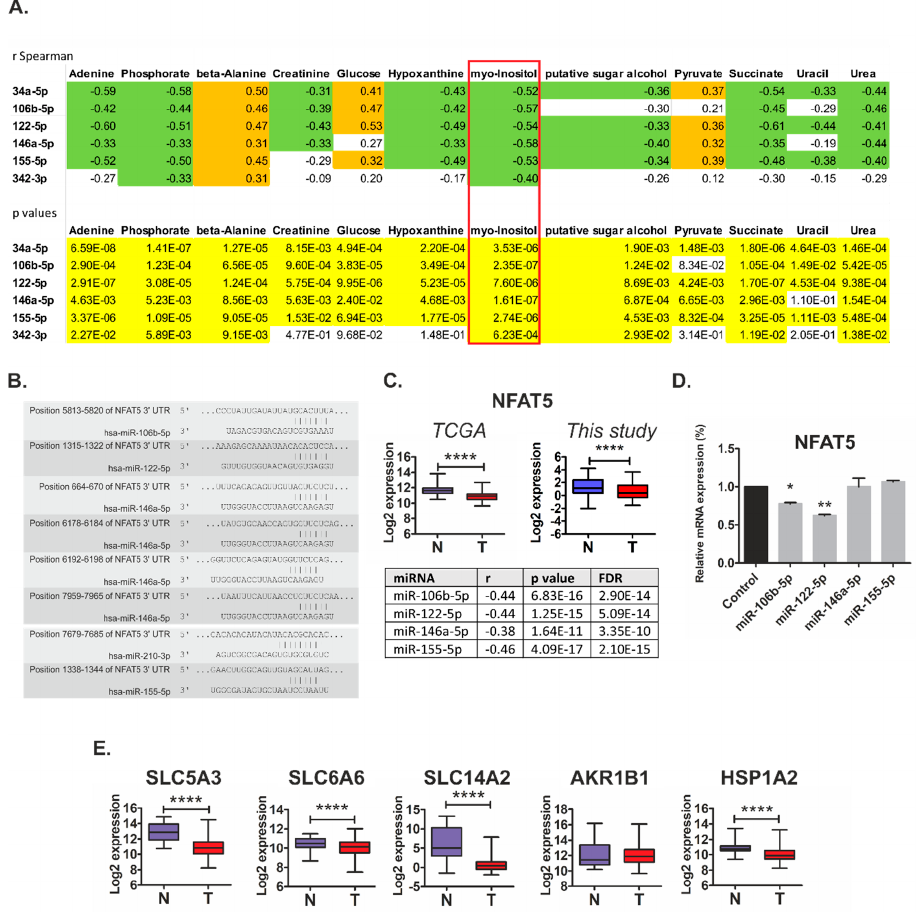
Figure 5. Osmoregulatory NFAT5 as a target of metabolically-relevant miRNAs in renal cancer. (A) Correlations between the expressions of microRNAs and metabolite levels in tissue samples from 70 control and RCC samples. Upper panel: Correlation coefficients. Orange: r Spearman > 0.3; green: r Spearman < − 0.3. Lower panel: p values; yellow: p < 0.05. Full data of correlation analysis is given in Table S6. ( B ) The potential binding sites of miRNAs in NFAT5 3 ′ UTR, predicted by TargetScan. (C) Upper panel: The expression of NFAT5 is decreased in RCC tumors (TCGA cohort: T, n = 250; this study cohort: T, n = 60) when compared with control kidney samples (TCGA cohort: C, n = 72; this study cohort: C, n = 60). Statistical analysis was performed using t-test. **** < 0.0001. Lower panel: Negative correlations between the expressions of NFAT5 and the predicted microRNAs.